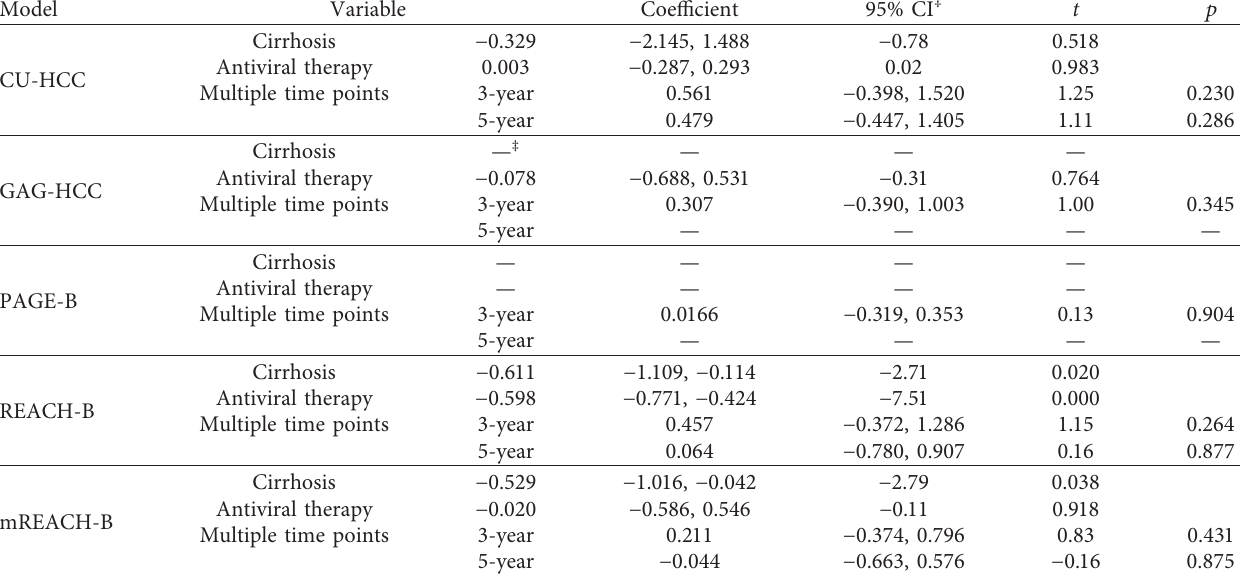
Table 4: The results of metaregression.